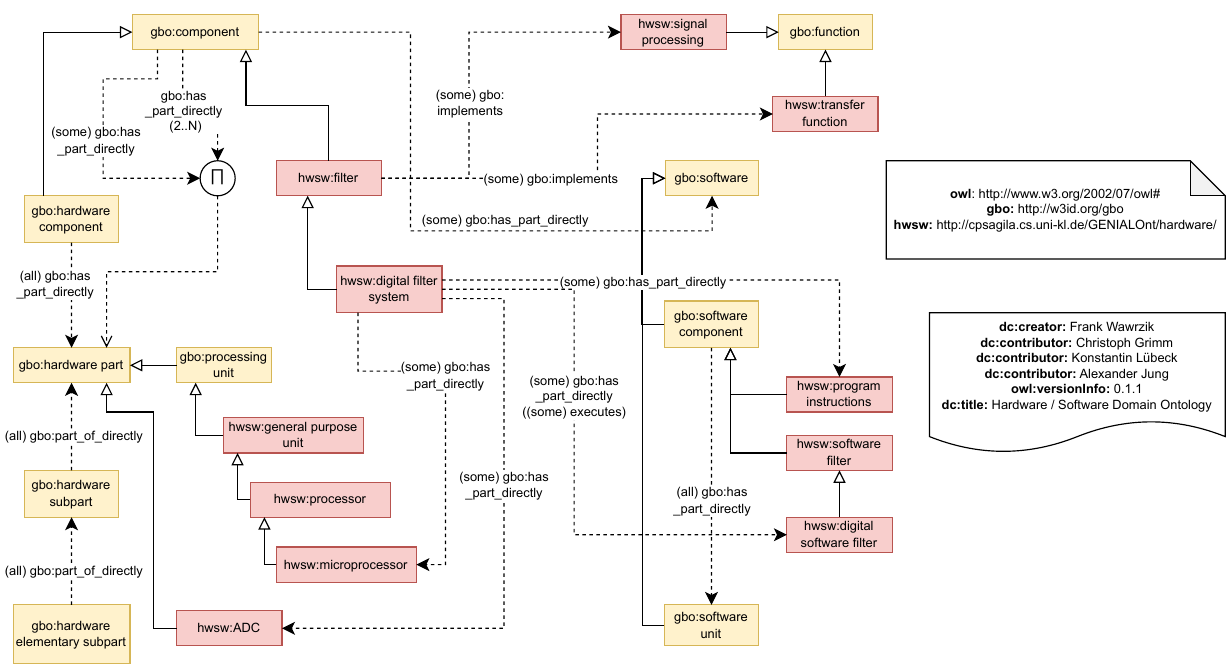
Figure 4. TBox reasoning of digital filter system